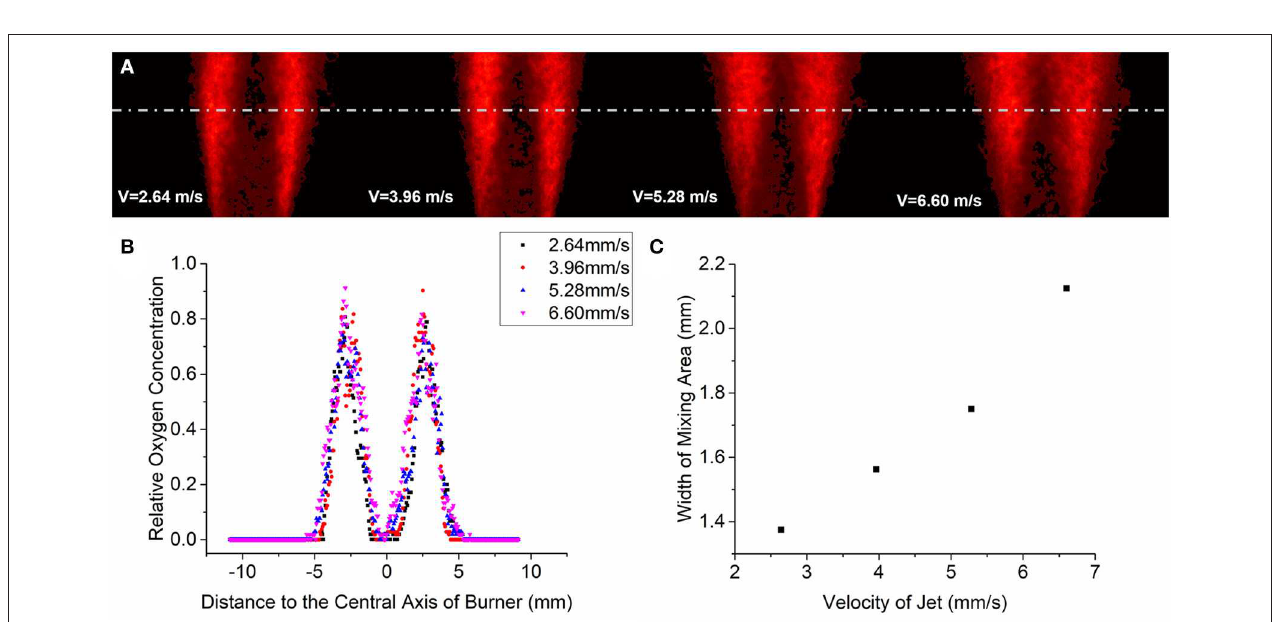
FIGURE 9 | Oxygen concentration distribution of the nozzle flow field (A) and 3D diagram (B) .